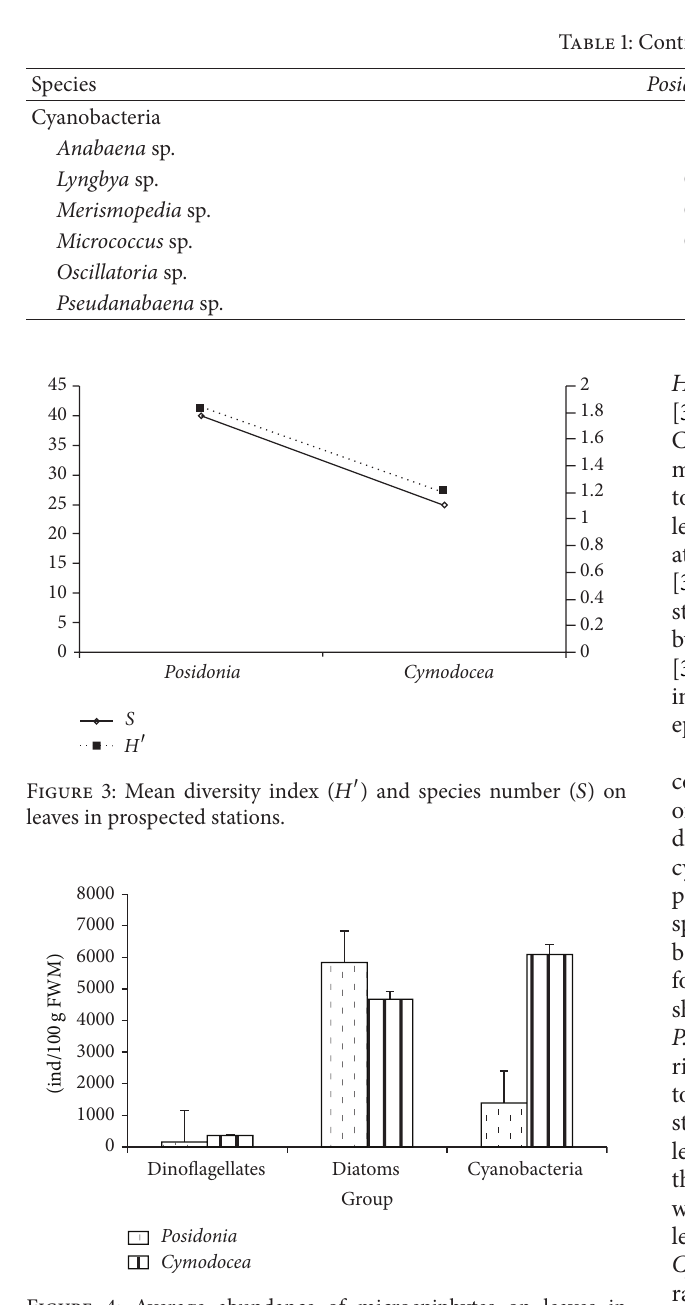
Figure 4: Average abundance of microepiphytes on leaves in prospected stations.